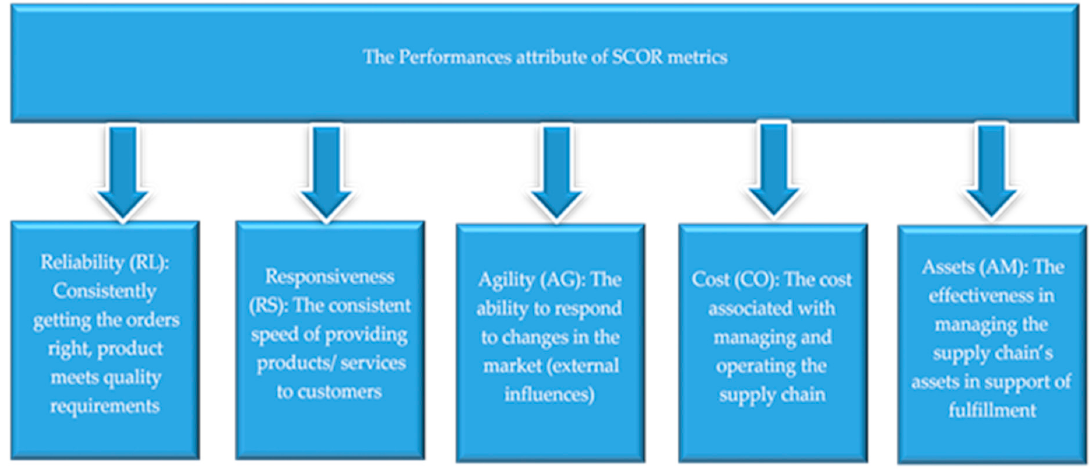
Figure 3. Performance attributes of the SCOR metrics.